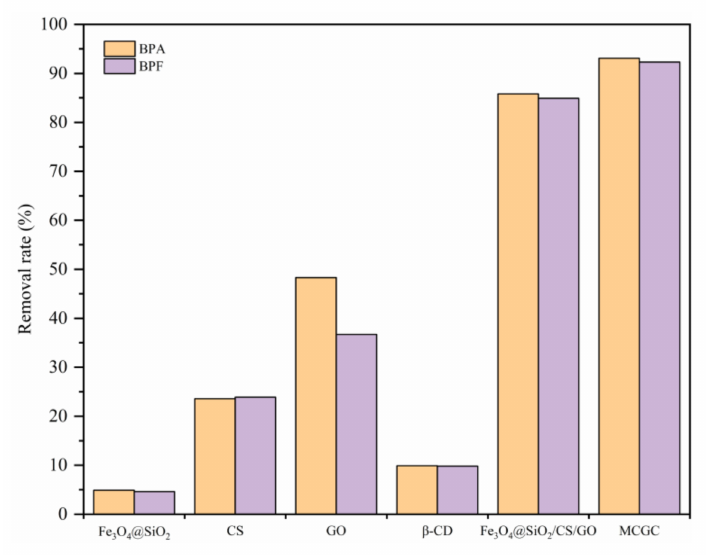
Figure 9. Ability of each component of the adsorbent to remove BPA and BPF in water (adsorbent amount 20 mg; adsorption time 60 min; shaking speed 200 rpm; temperature 30 °C; initial concentration 20 mg / L; volume 50 mL; pH